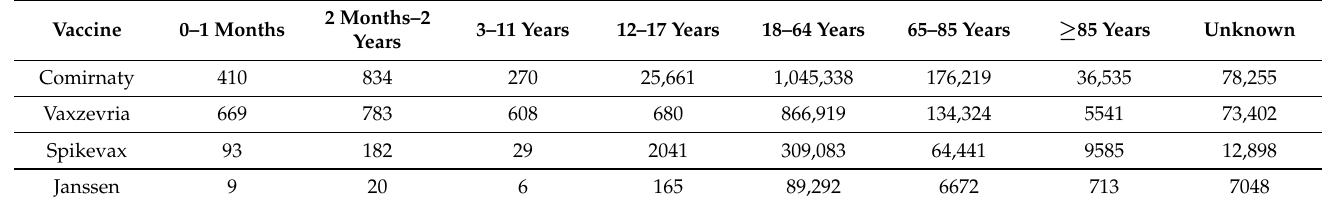
Table 12. Comparative analysis of vaccines by